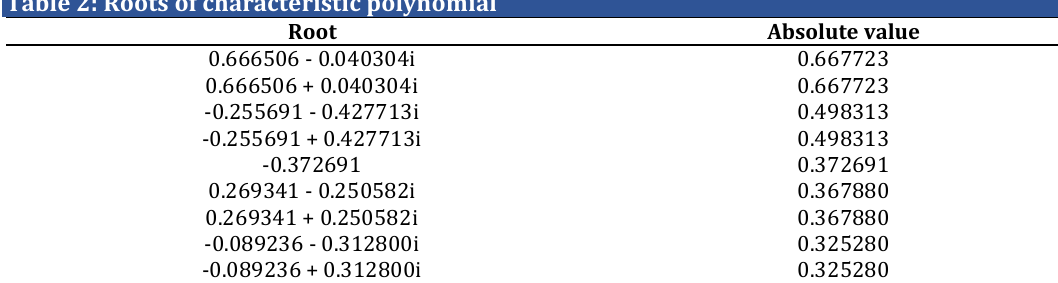
Table 2: Roots of characteristic polynomial